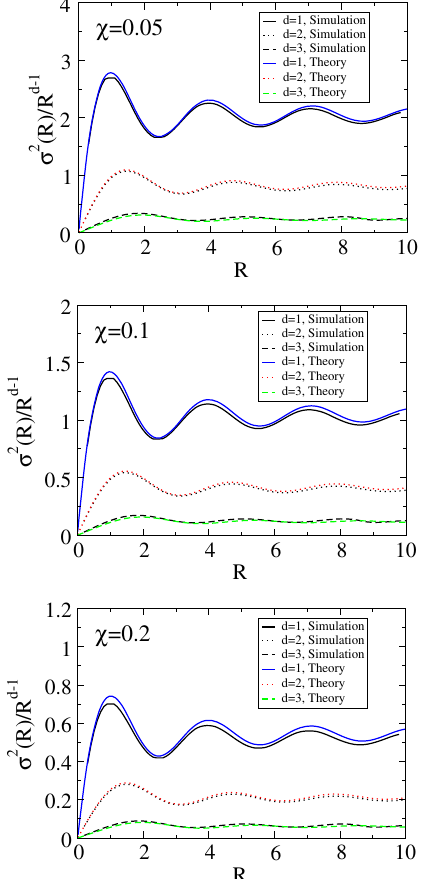
FIG. 9. Comparison of analytical and numerical results for the number variance for χ ¼ 0 . 05 , 0.1, and 0.2 across the first three space dimensions. Here, K ¼ 1